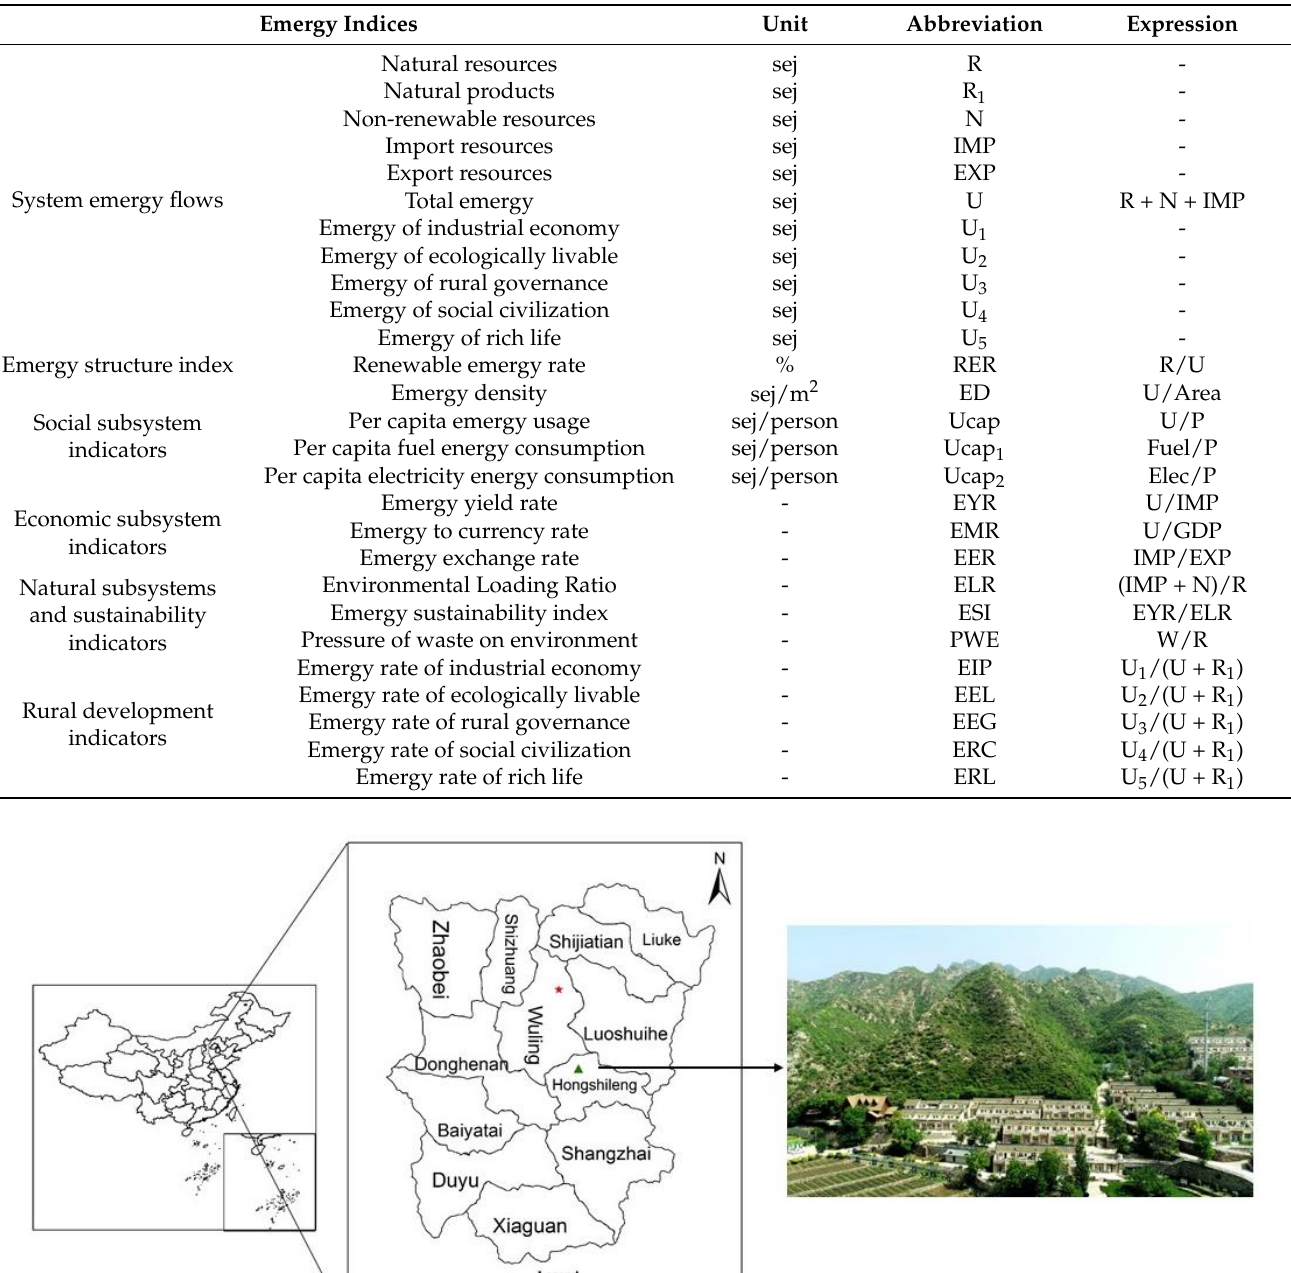
Table 1. Emergy indices of rural ecosystem.